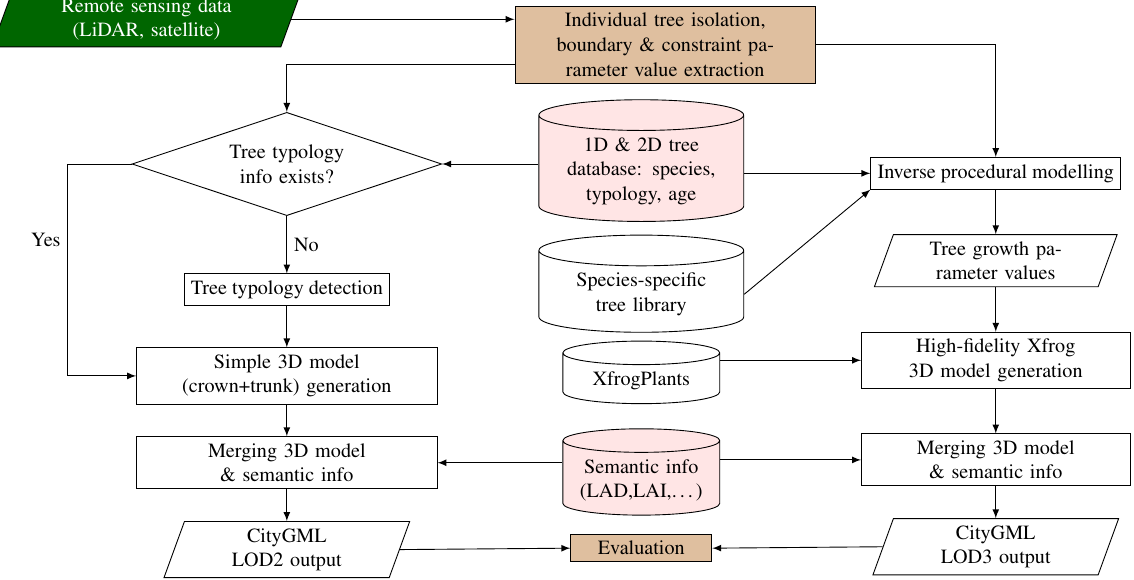
Figure 3. Framework